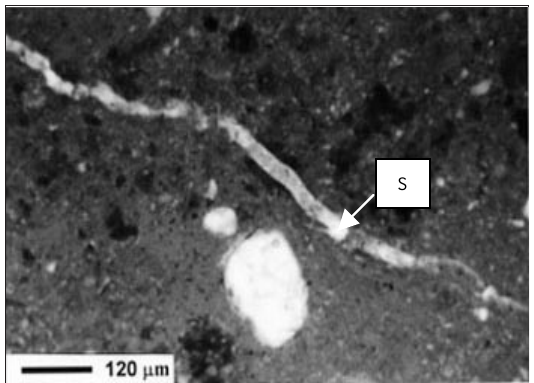
Figura 4. Fotomicrografia em nicóis cruzados do horizonte Bi3 do CeTa (P1), mostrando uma fenda preenchida por material silicoso